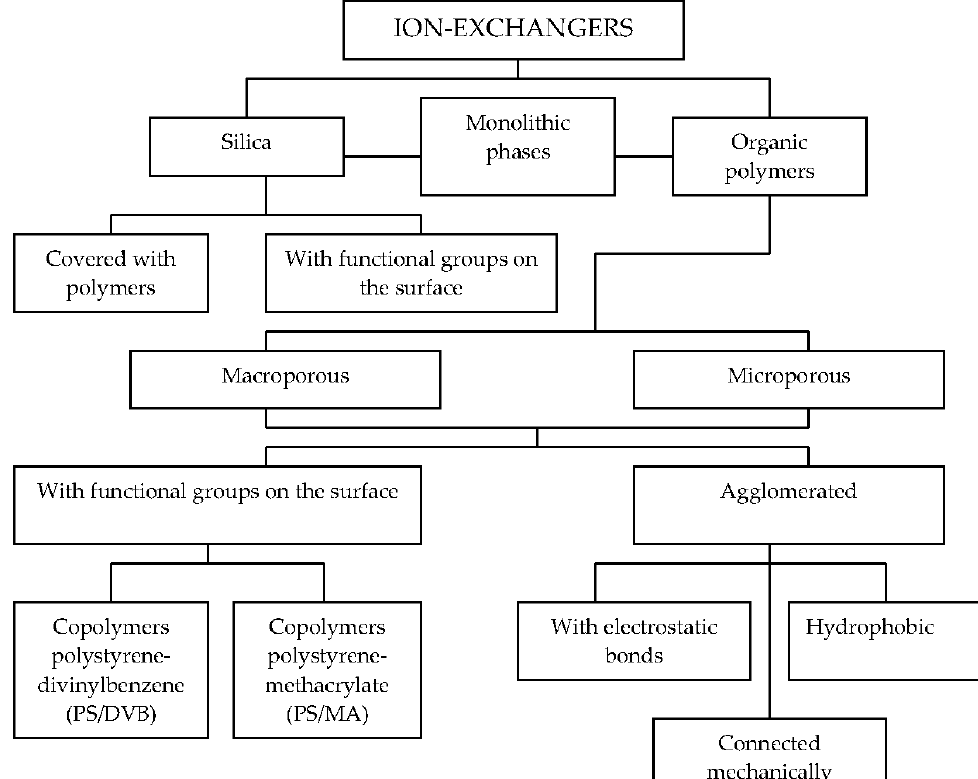
Figure 1. Stationary phases used in ion chromatography.